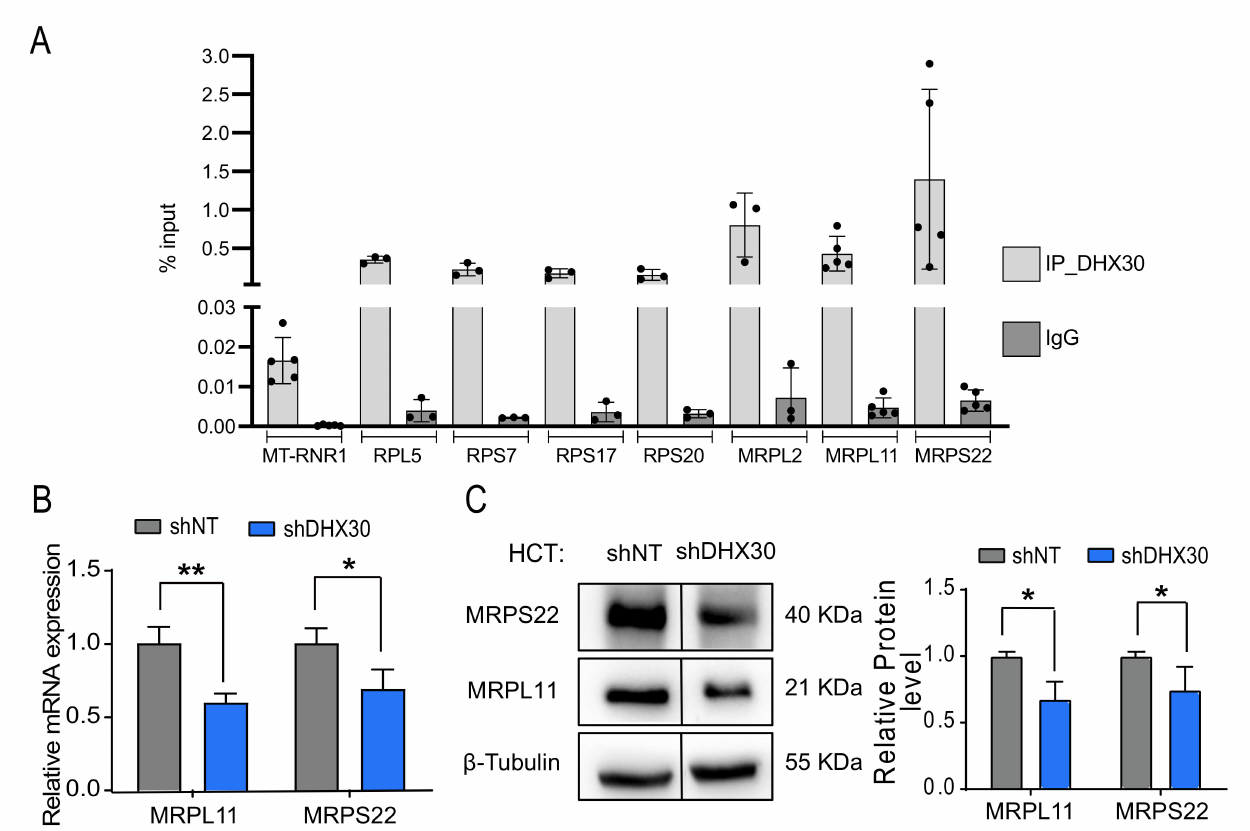
Figure 2. Cytoplasmic DHX30 modulates the expression of nuclear encoded mitoribosome components MRPL11 and MPRS22. ( A ) RIP experiments in parental HCT116 cells were performed to study the binding of DHX30 to the indicated RPs and MRPs transcripts. Results obtained with a primary antibody targeting DHX30 (light gray) or the IgG control (dark gray) are plotted as % of input. Data are mean and individual points (3 to 5 replicates). ( B ) Relative mRNA levels of MRPL11 and MRPS22 in HCT116_shDHX30 compared to the shNT control clone. Data are mean ± SD (n = 3); * p < 0.05; ** p < 0.01, t -test. ( C ) (Left) Protein levels of MRPL11 and MRPS22. β -Tubulin was used as loading control. Immunoblots represent one of three independent experiments. The vertical lines indicate that the membrane was cut to remove a Nutlin-treated sample that was not relevant to this figure. (Right) MRPL11 and MRPS22 protein quantification in HCT116_shDHX30 normalized on shNT control clone. Data are mean ± SD (n = 3); * p < 0.05, t -test. The uncropped blots are shown in supplementary